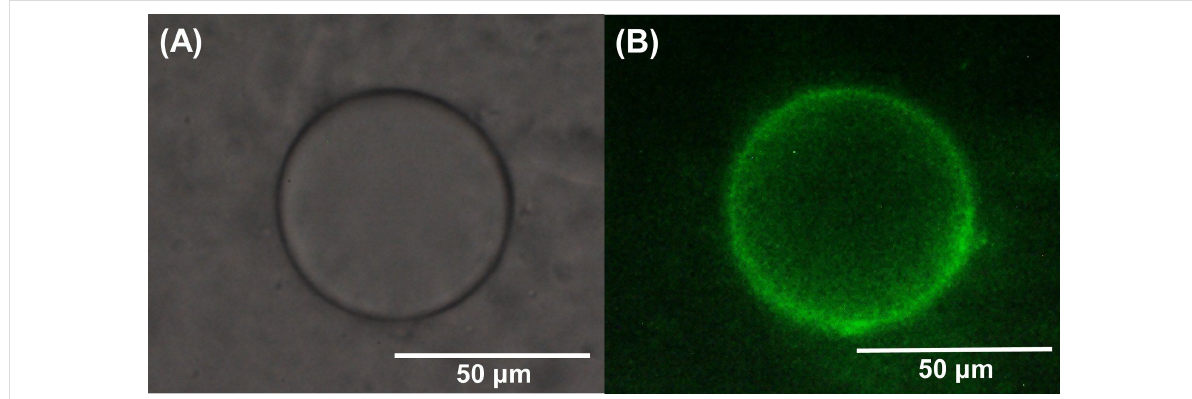
Figure 6: (A) Optical and (B) fluorescence micrographs of the n -dodecane-in-water emulsion stabilized by the FITC-labeled DM- β -CD/PDI nanogel before (A) and after (B) observations with the filter sets (excitation wavelength: 470 nm and emission wavelength: >510 nm).